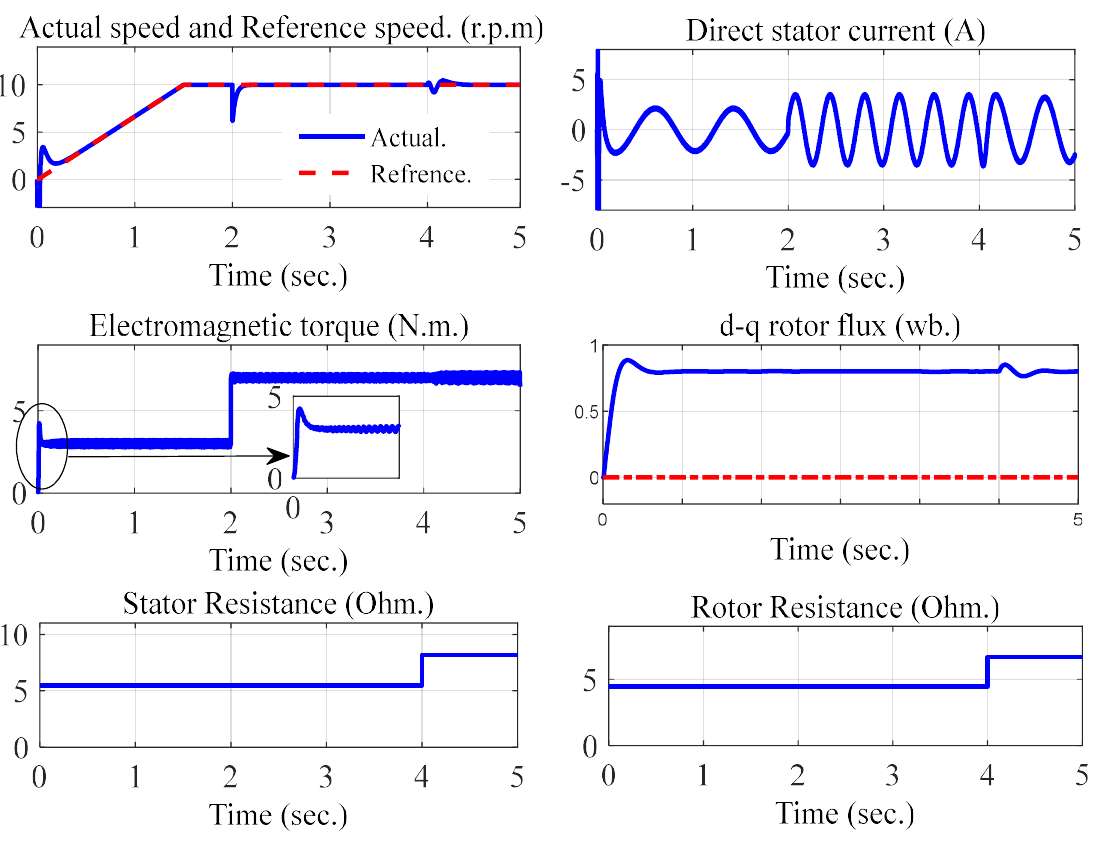
Figure 9. Performance of IFOC IM drives at load disturbance and parameter variation in low-speed operation.